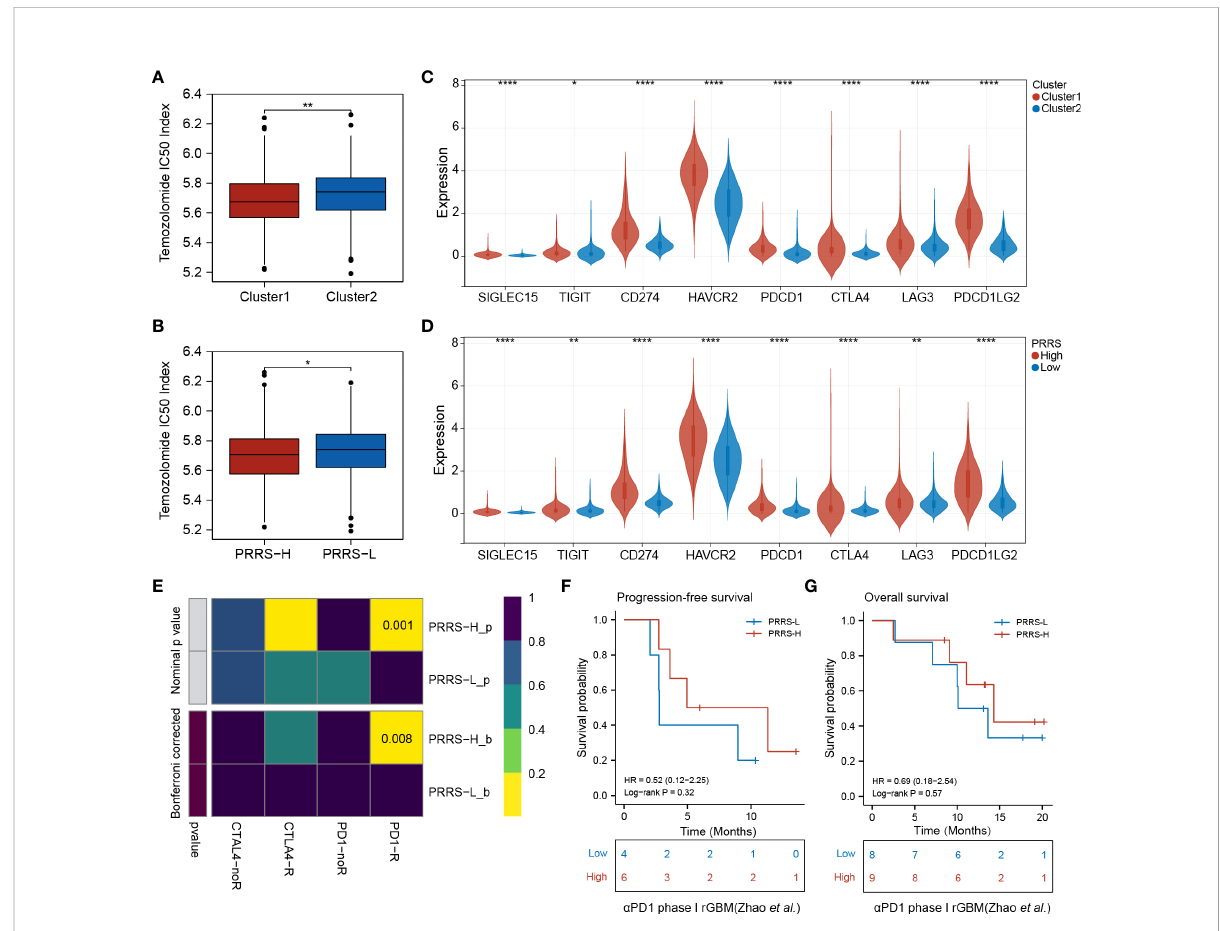
FIGURE 8 Pyroptosis-related cluster and PRRS are associated with survival bene fi ts from temozolomide and immunotherapy. (A) Predicted TMZ sensitivity in Cluster 1 and Cluster 2. (B) Predicted TMZ sensitivity in high- and low-PRRS group. (C) Expression levels of immune checkpoints in Cluster 1 and Cluster 2. (D) Expression levels of immune checkpoints in high- and low-PRRS group. (E) Submap analysis of the predicted response to anti-CTLA4 and anti-PD1 in high- and low-PRRS group. (F) Survival analysis for progression-free survival between low- and high-PRRS group. (G) Survival analysis for overall survival between low- and high-PRRS group. *P < 0.05; **P < 0.005; ****P <